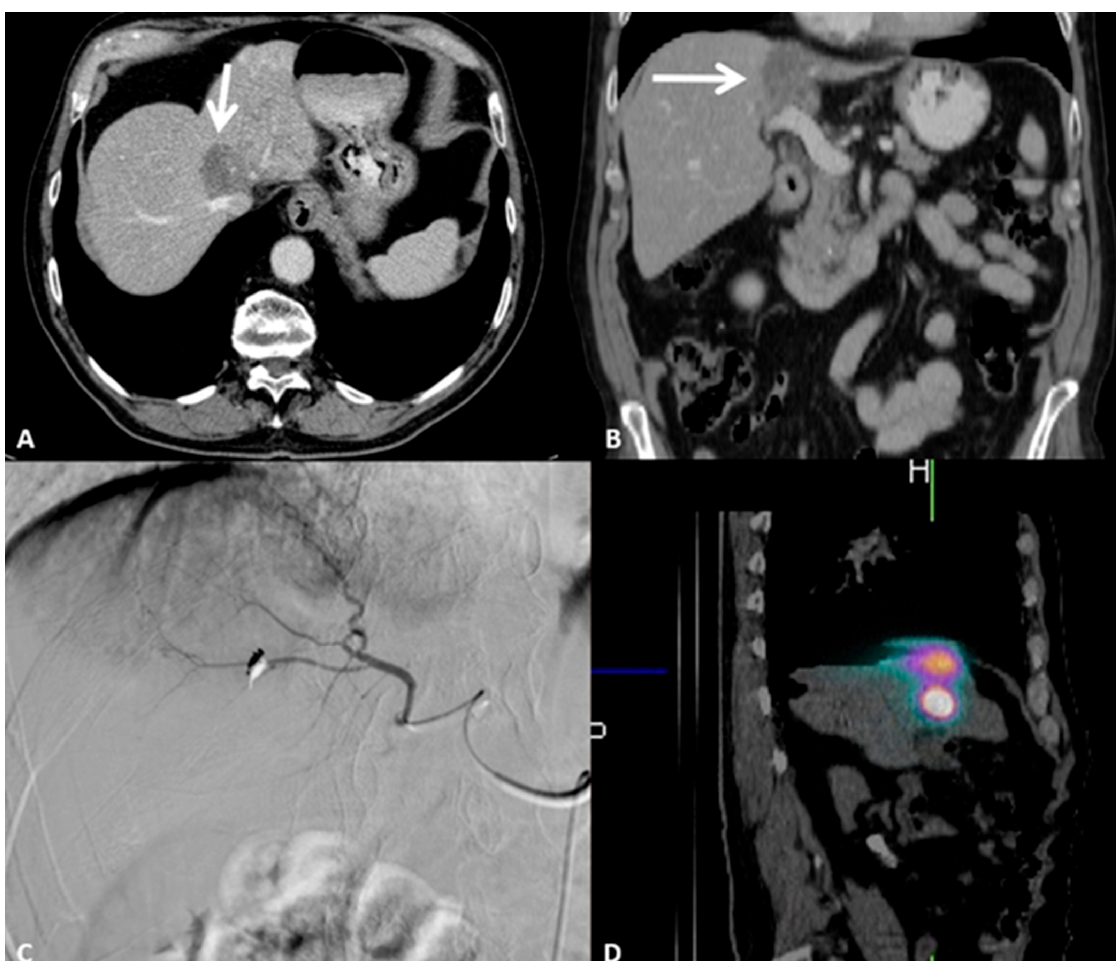
Figure 8. 79-year-old male patient presenting with pain in the right upper abdominal quadrant due to intrahepatic cholangiocellular carcinoma. Performance Status One, no surgical indication; the patient underwent eight cycles of chemotherapy. ( A ) Contrast-enhanced axial CT scan showing a 3.5 cm lesion of the I-IV segment adjacent to the inferior vena cava and to the right hepatic vein. ( B ) Contrast-enhanced coronal CT scan showing how the lesion is adjacent to the portal vein. ( C ) Digital subtraction angiography runs showing super selective catheterization of the target vessel with intra-arterial administration of marked albumin macroaggregates, which serve as the diagnostic phase of radioembolization. ( D ) Single-photon emission computed tomography oblique reconstruction scan showing focal and selective uptake of marked albumin macroaggregates by the target lesion, confirming the catheter position for the therapeutic radioembolization.